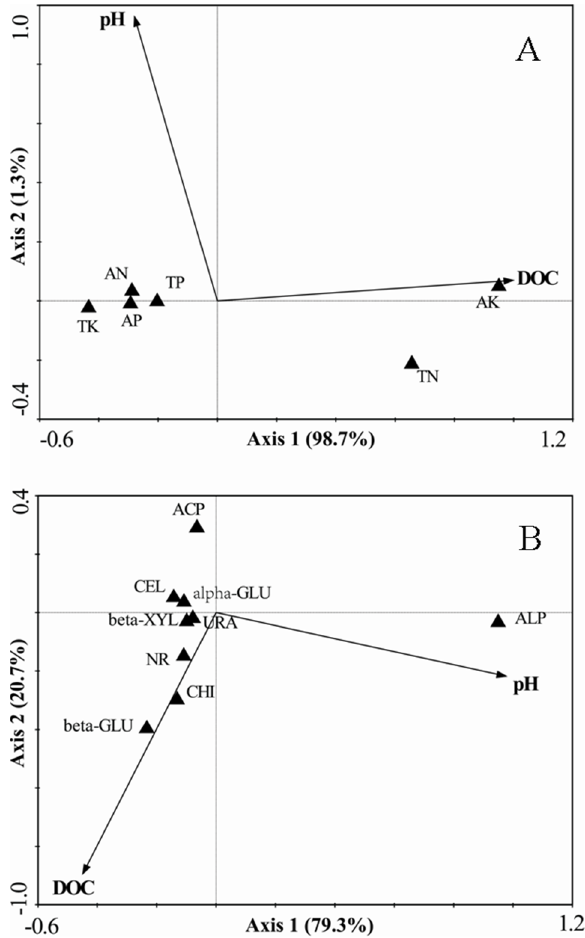
Figure 4. Canonical correspondence analysis (CCA) of the explanatory variables (pH and DOC) and the response variables, soil chemical properties ( A ) or soil enzyme activities ( B ). TN, total nitrogen; AN, available nitrogen; TP, total phosphorus; AP, available phosphorus; TK, total potassium; AK, available potassium; α -GLU, α -glucosidase; β -GLU, β -glucosidase; β -XYL, β -xylosidase; CEL, cellobiosidase; URA, urase; NR, nitrate reductase; CHI, chitinase; ACP, acid phosphatase; ALP, alkaline phosphatase.